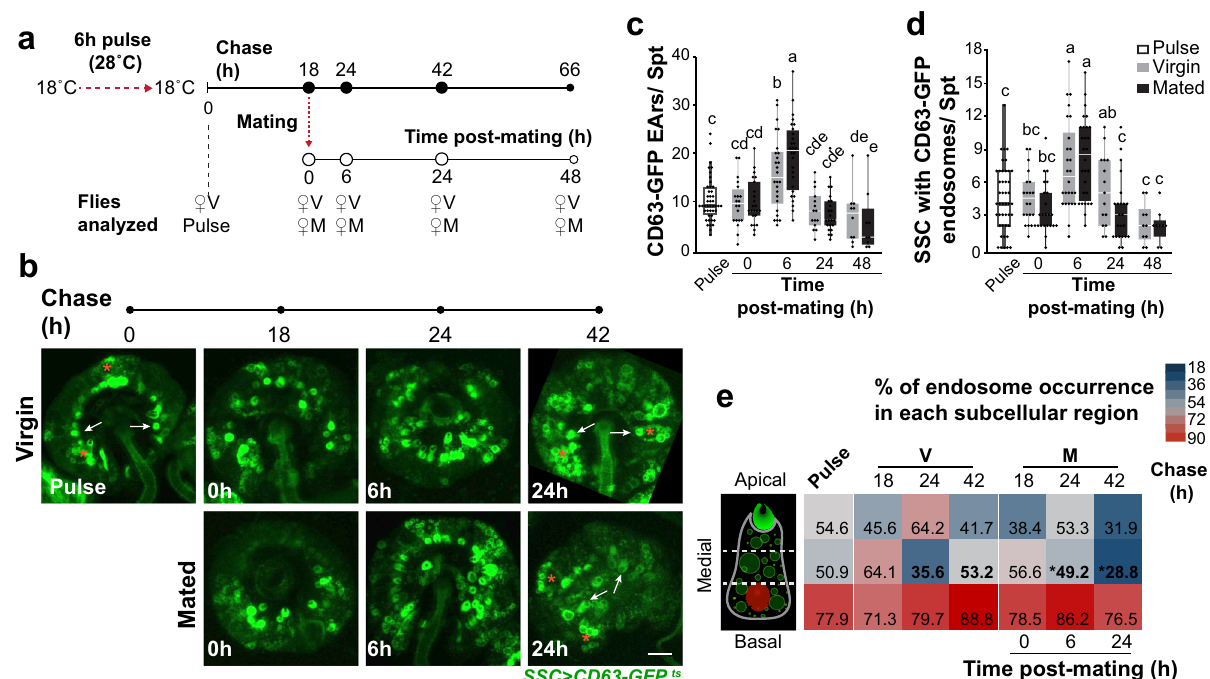
Fig. 4 Mating changes the CD63-GFP traf fi cking dynamics in the SSC. a Schematic that describes the pulse-chase experimental design: pulse duration, CD63-GFP chase time (full circles), time of sampling virgin (V) and mated (M) females (empty circles). b Representative confocal maximum projection images of virgin and mated spermatheca expressing CD63-GFP; arrows and stars denote SSC with CD63-GFP-positive EAr and endosomes, respectively. Scale bar = 20 µ m. c Average number of CD63-GFP-positive EAr in the spermatheca at different times post pulse and mating. d Average number of SSC with CD63-GFP-positive endosomes in the spermatheca at different times post pulse and mating (see also Supplementary Fig. 4a, c). Bars represent the mean ± SE, n = 10 – 28 spermathecae from 7 – 17 fl ies per condition; letters denote signi fi cant differences analyzed by two-way ANOVA and Tukey HSD multiple comparison post-hoc test p < 0.05. e Heatmap depicting the percentage of endosomes detected in different subcellular regions (apical, medial or basal) within the SSC of virgin or mated females at different time post-mating (Supplementary Fig. 4b). Stars and bold numbers in the heatmap highlight signi fi cant difference (one-way ANOVA, p <